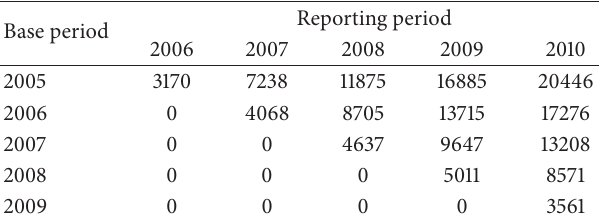
Table 9: Income mobility of urban residents in different periods from 2005 to